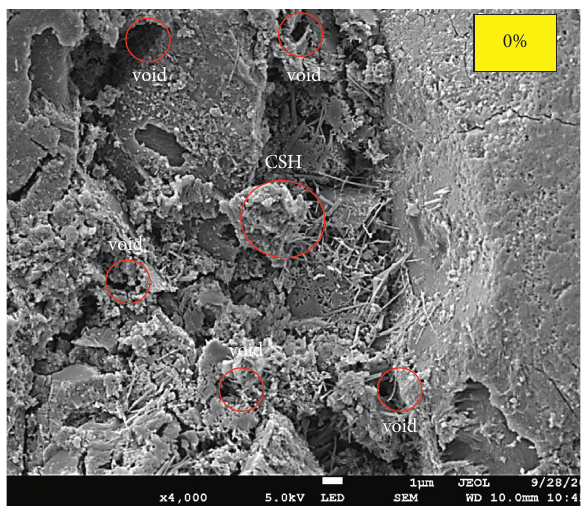
Figure 24: Microstructure of POC LWAC containing 0% spent garnet after exposure to hydrochloric solution at 28days.